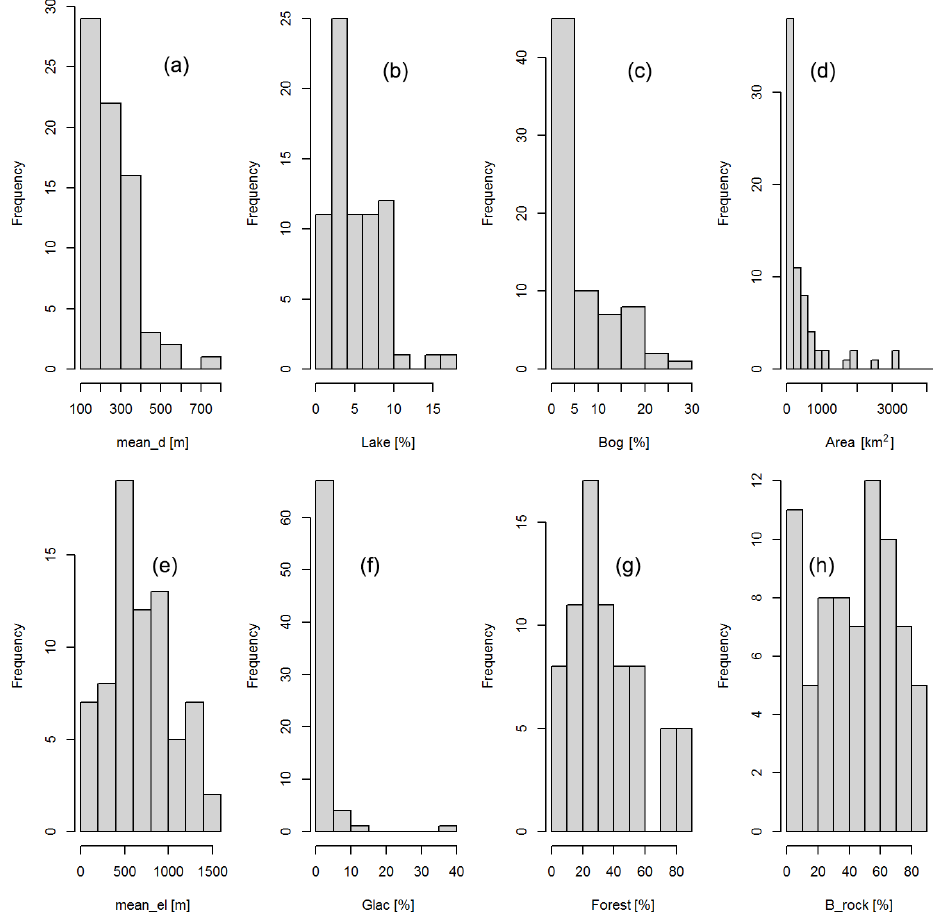
Figure 4. Histograms of catchment characteristics for the 71 catchments: (a) mean of the hillslope distance distribution, d ; (b) areal percent- age of lakes; (c) areal percentage of bogs; (d) catchment area; (e) mean elevation; (f) areal percentage of glaciers; (g) areal percentage of forests; and (h) areal percentage of bare rock.